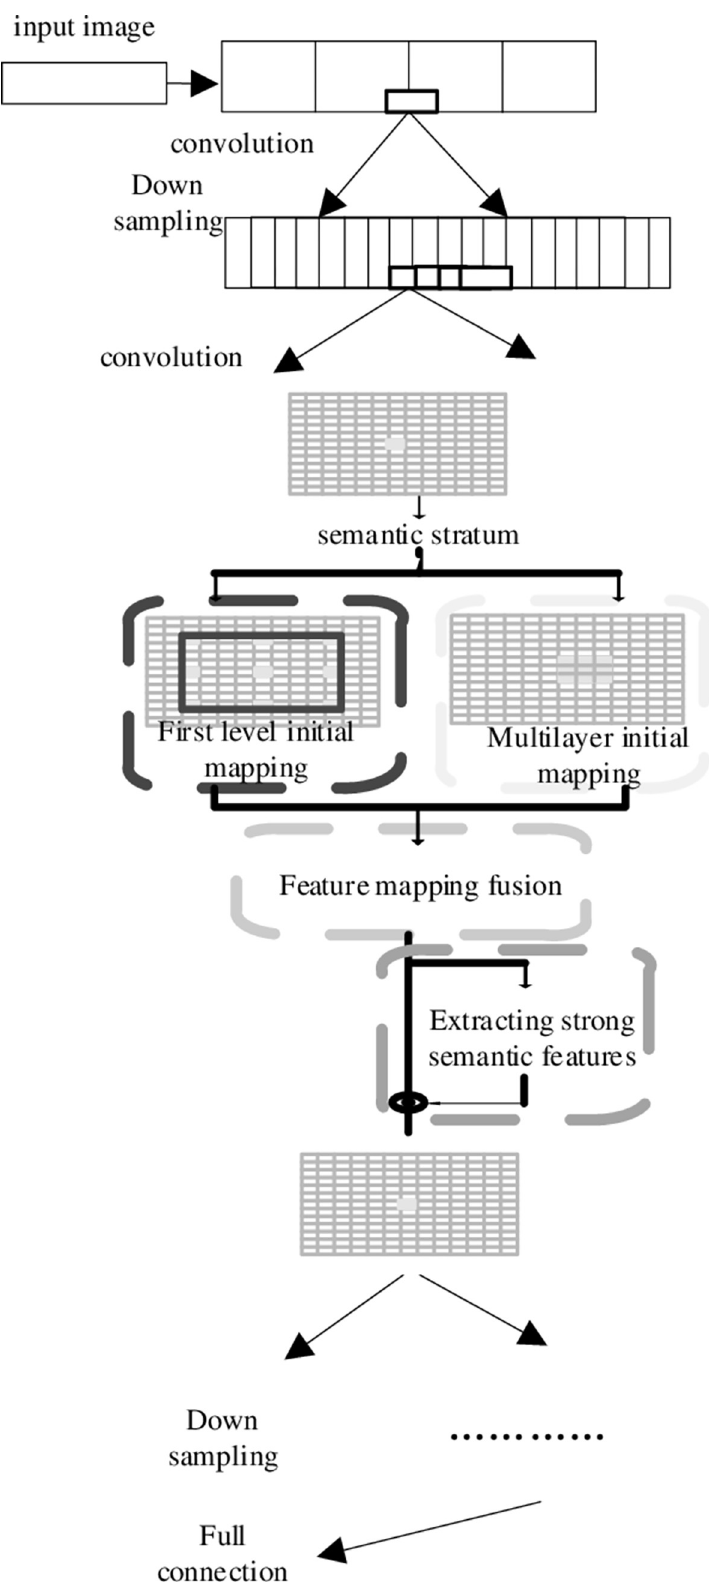
Fig 1. Convolution neural network edge segmentation process of computed tomography image sequence. https://doi.org/10.1371/journal.pone.0265338.g001 PLOS ONE | https://doi.org/10.1371/journal.pone.0265338 June 3,